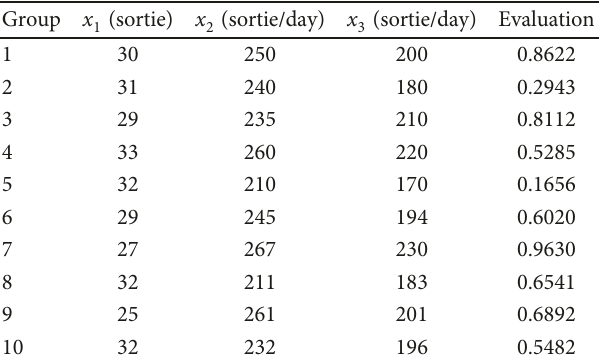
Table 3: Sortie generation rate capacity.